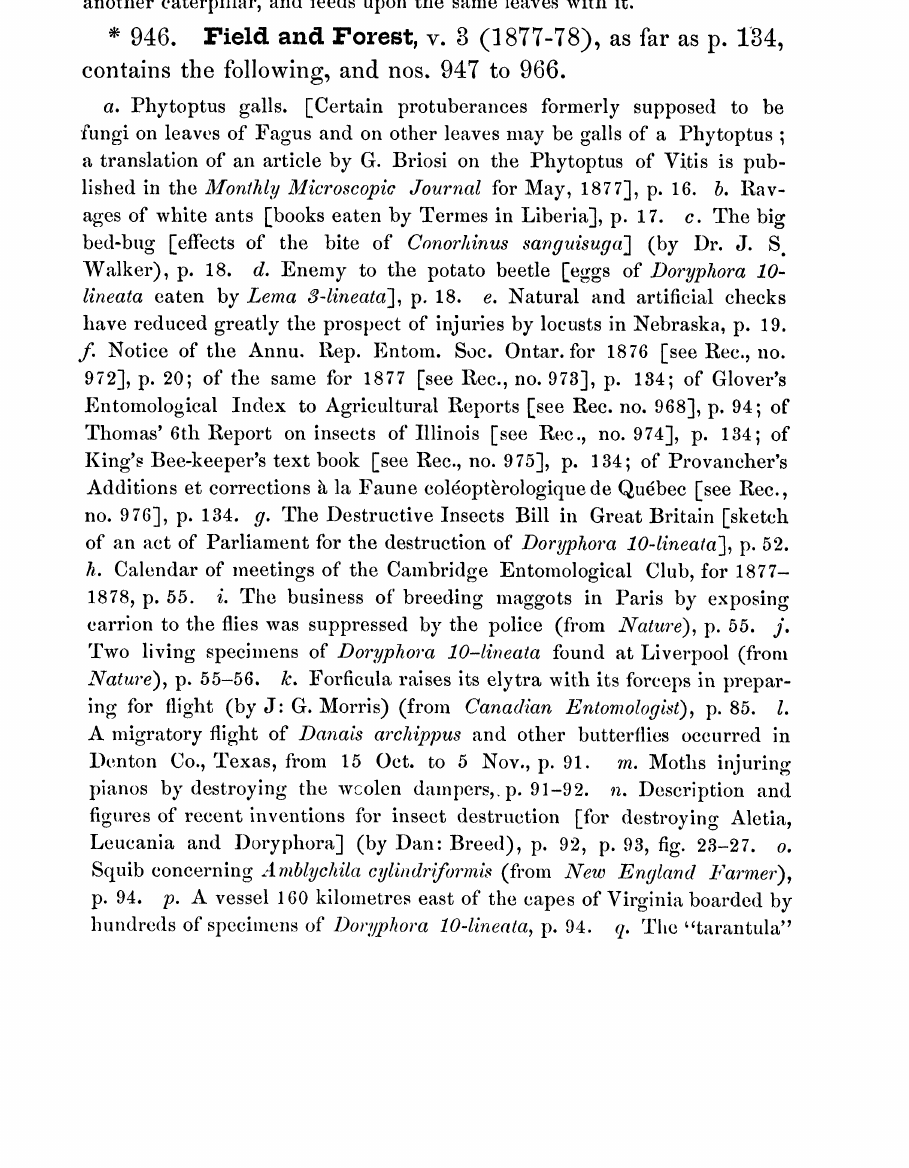
A minie ball gnawed through by the larva of an Orthosoma? [Hagen FTZ MUnLLn (in